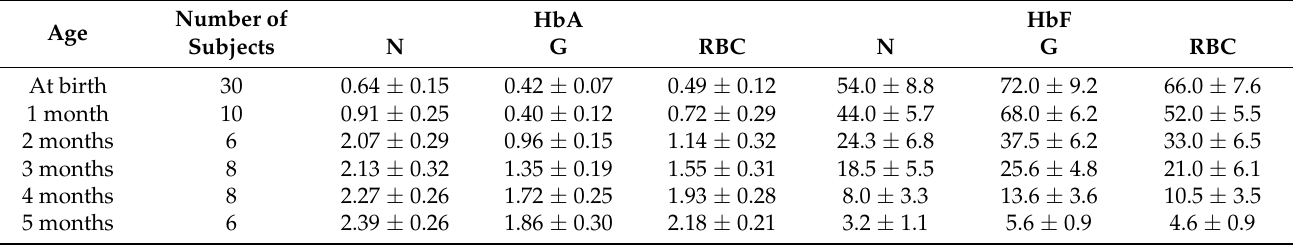
Table adapted from [20]. Values are means (SD); the statistical significance between subjects was tested by one-tailed Student t test. Hb, haemoblobin; MCH mean cell haemoglobin, mean cell volume; NS not significant. Table 9. HbA, HbF ( ± SD), red blood cells (RBC) before and after separation in density gradient of neocytes (N) and gerocytes (G) during the 1st year of